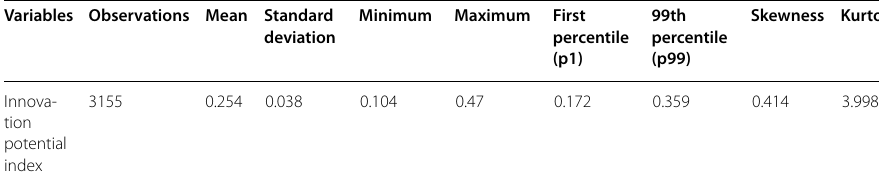
Table 5 Descriptives of the innovation potential index